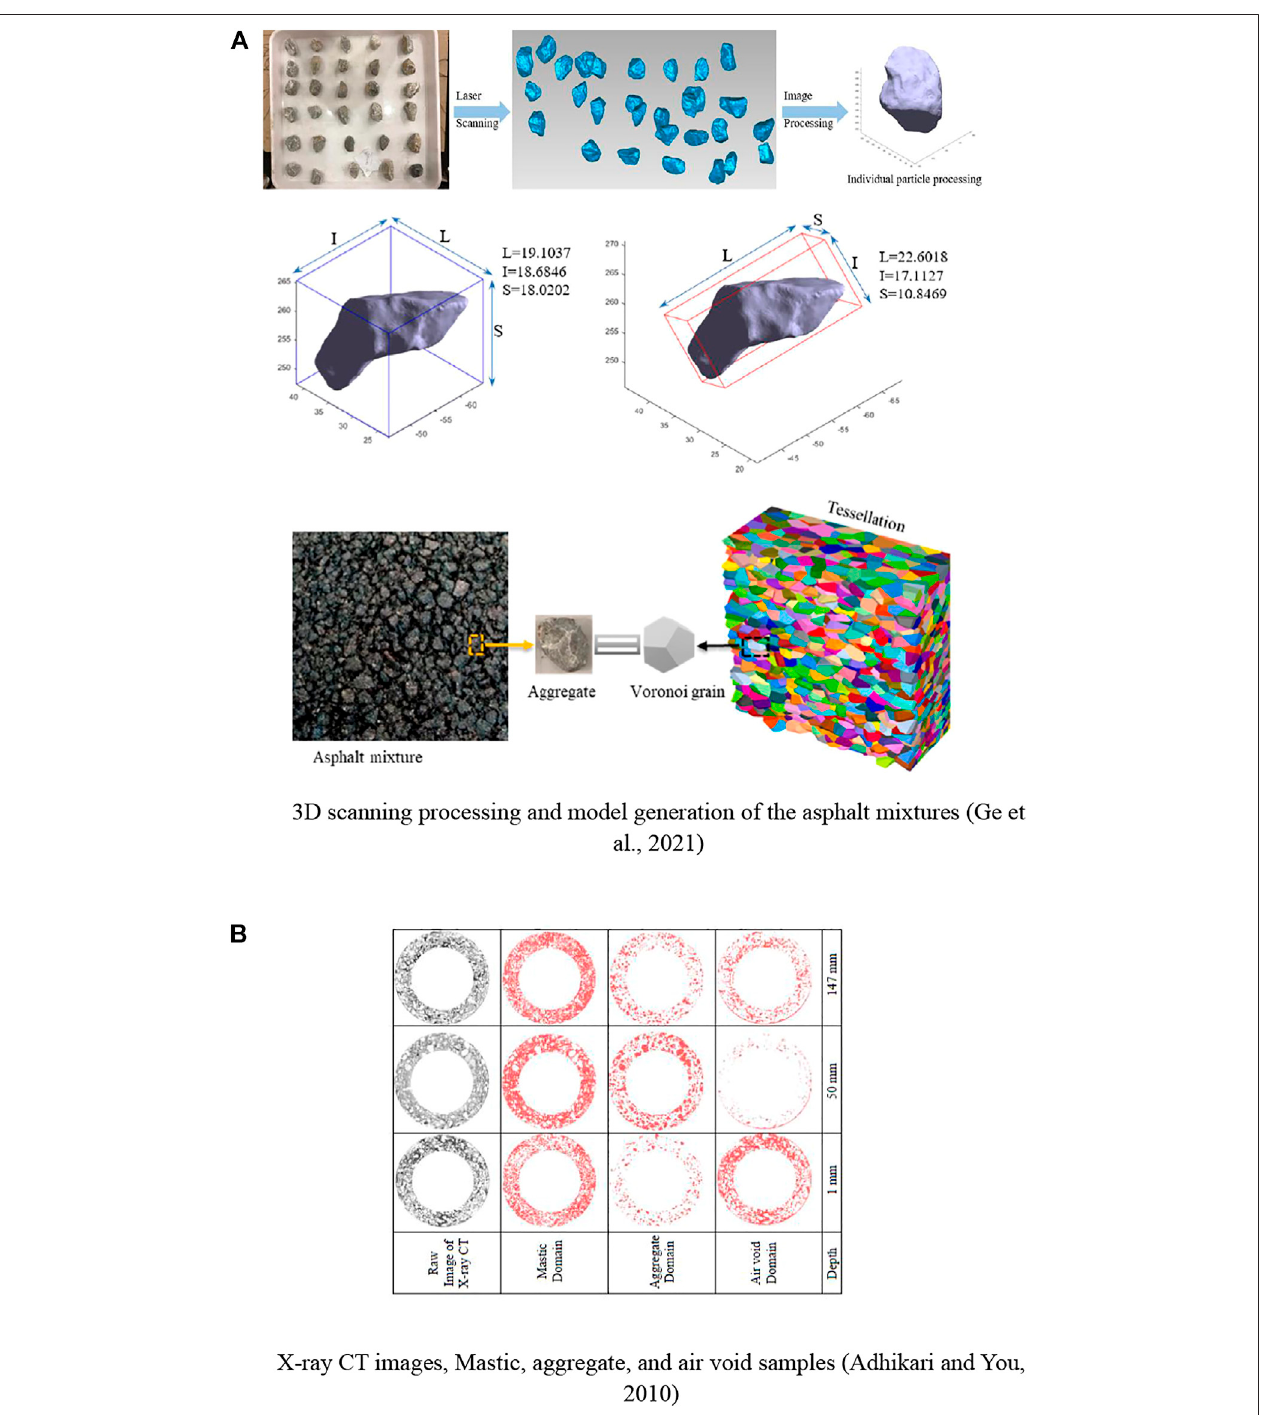
FIGURE 8 | 3D DEM scanning samples and digital generation specimens (Ge et al., 2021; Adhikari and You, 2010). (A) 3D scanning processingand model generation of the asphalt mixtures (Ge et al., 2021). (B) X-ray CT images, Mastic, aggregate, andair void samples (Adhikari and You, 2010).